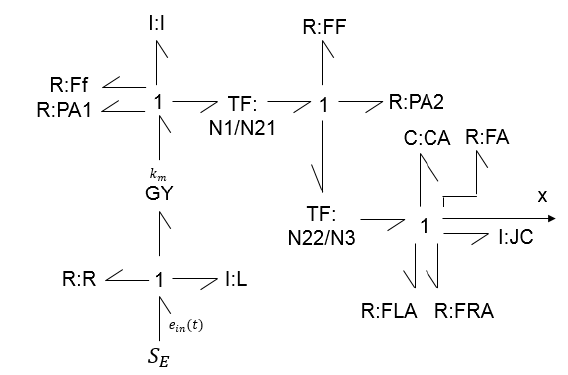
Figure 5. Bond graph of the ACV